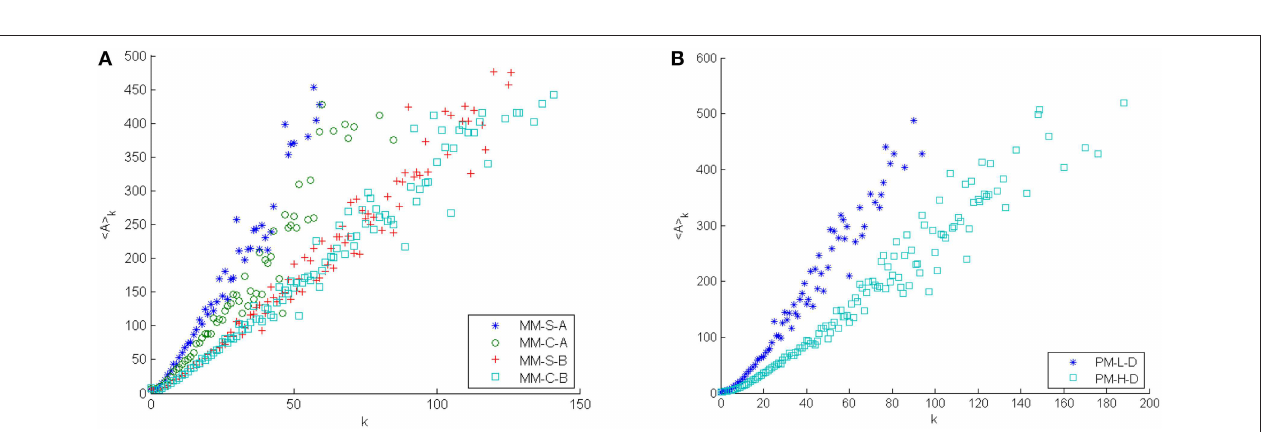
FIGURE 5 | Averaging the area for all fractures with similar degree shows a clear connection between length and degree. Results are based on 50 samples of each two-dimensional DFN model. (A) Results for the mechanical model in all limits. (B) Results for the Poissonian model in both limits as well as the outcrops.